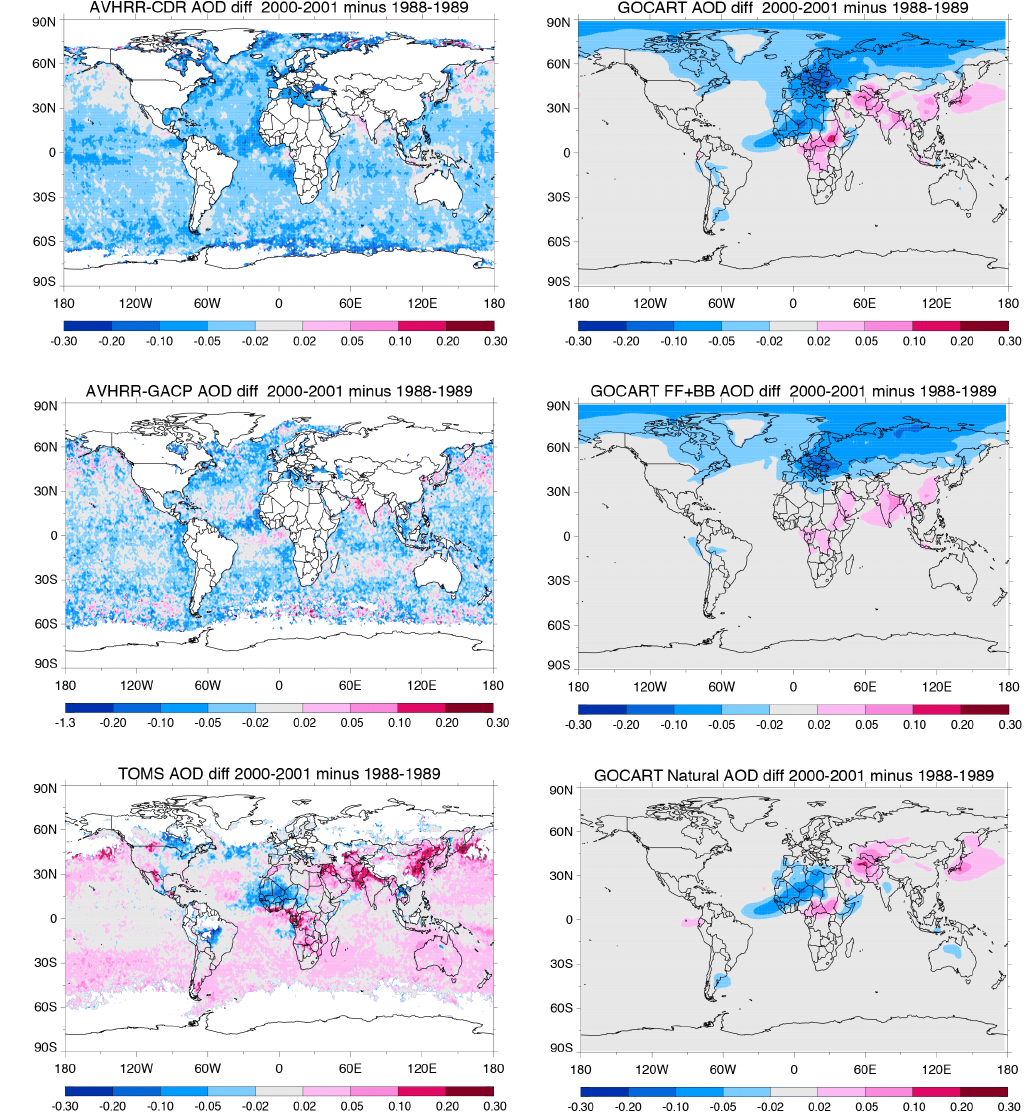
Fig. 11a. Difference of AOD between 2000–2001 and 1988–1989 from satellite data (left column, from top: AVHRR-CDR, AVHRR-GACP, and TOMS) and GOCART simulations (right column, from top: total, FF + BB, and natural AOD). White area indicates no